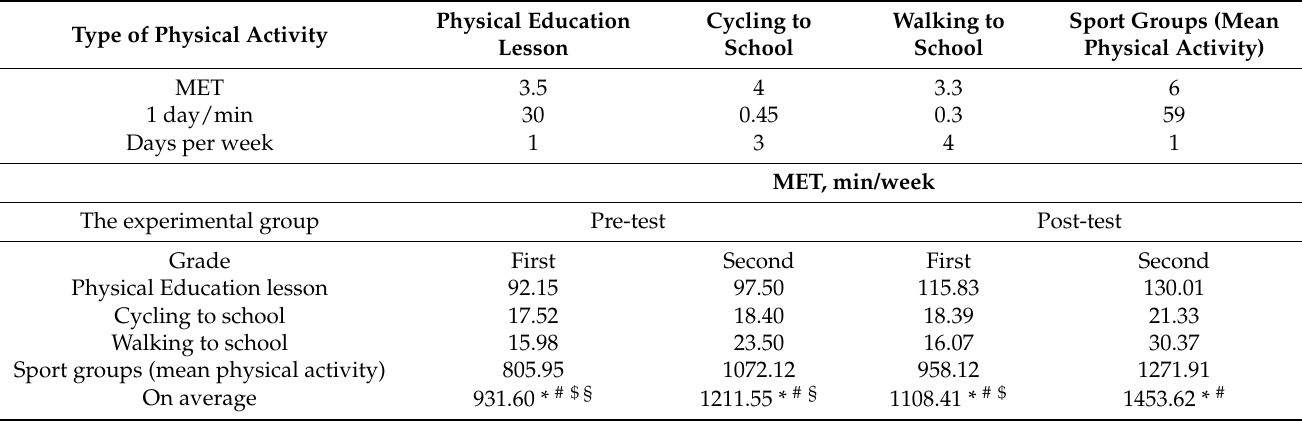
Table 3. Physical activity levels determined using the MET